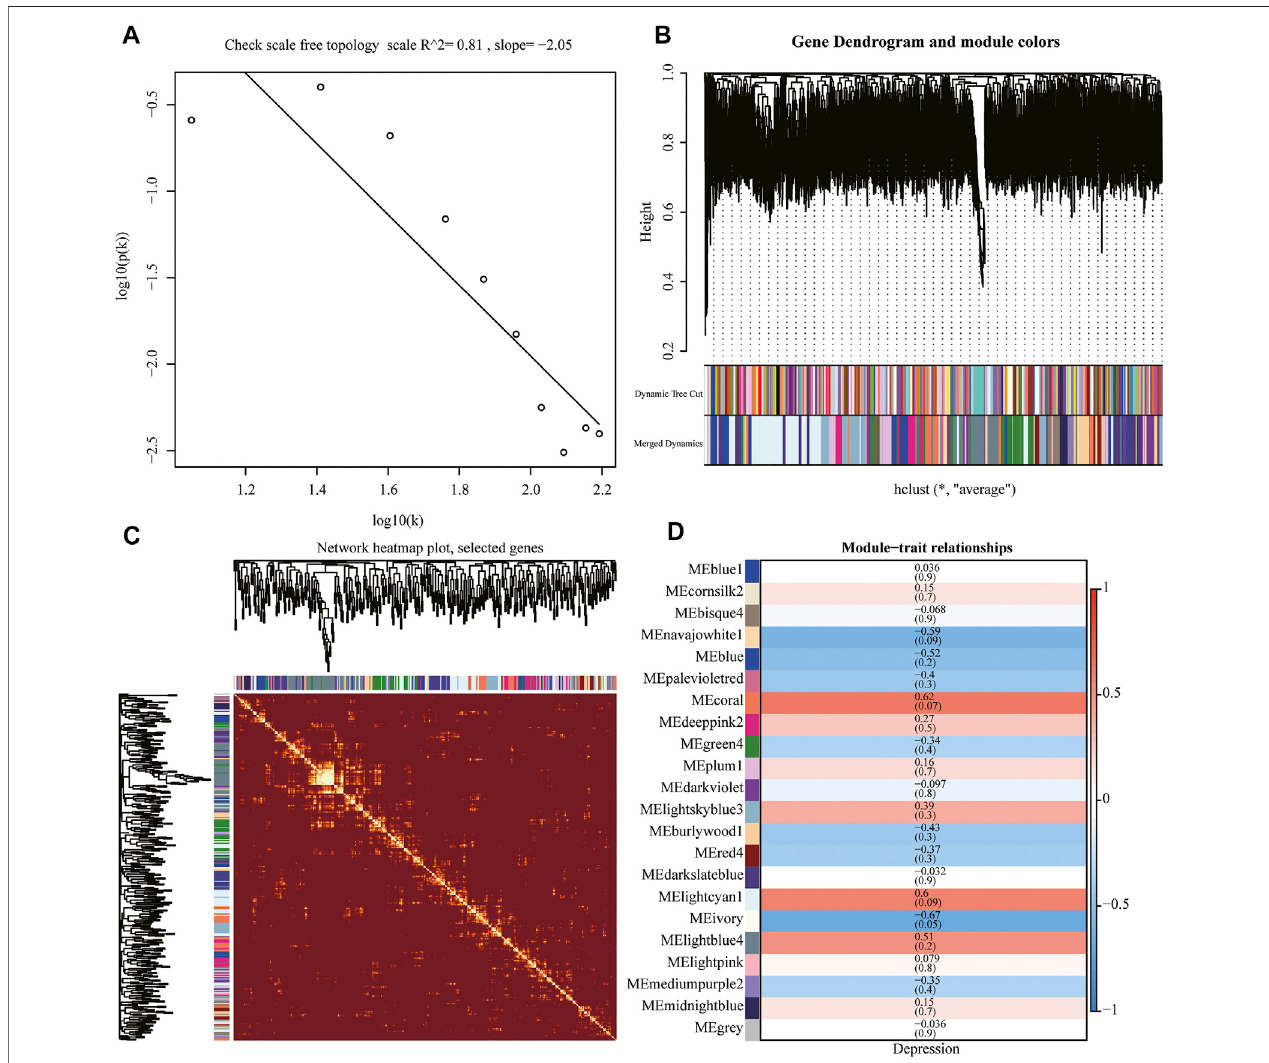
FIGURE 7 | Weighted gene co-expression network analysis (WGCNA). (A) Scale-freenetwork veri fi cation graph (R 2 > 0.8, slope < 0), conforming tothe scale-free network standard. (B) Dynamic clipping tree clustering diagram; the abscissa is the clustering module and ordinate is the tree height. (C) TOM network clustering heatmap. (D) Heat map of correlations between WGCNA network modules and